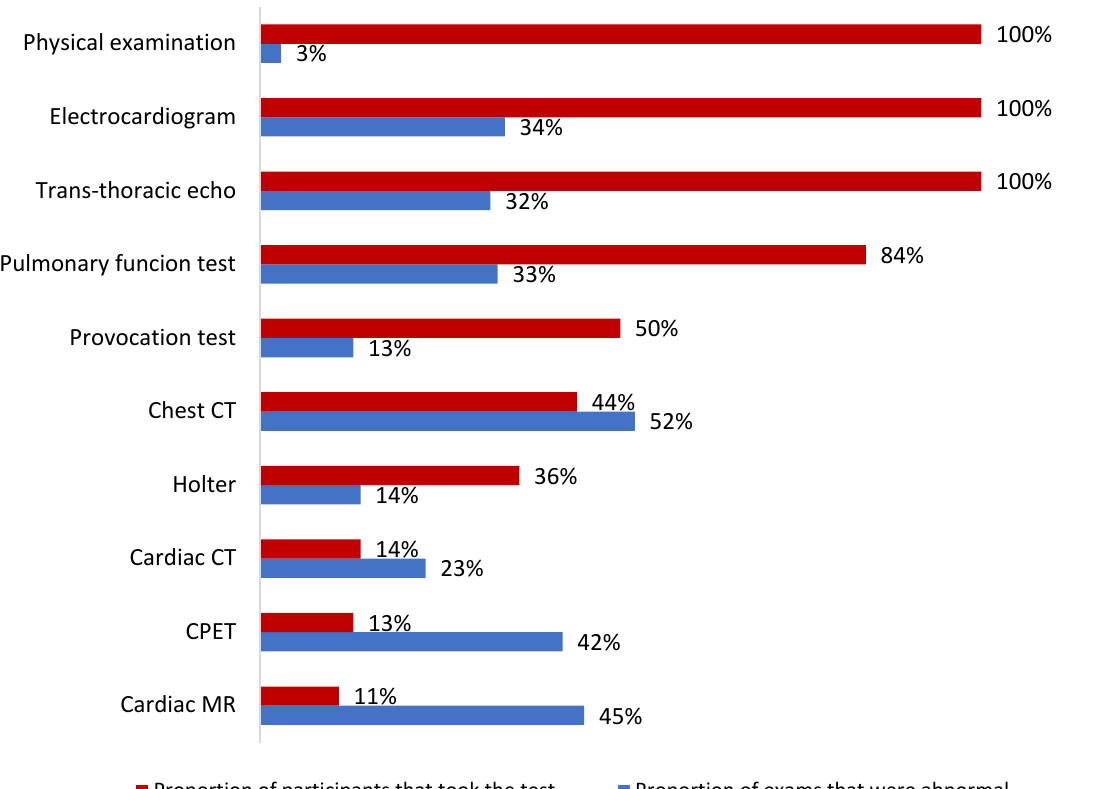
Figure 3. Diagnostic tests performed on the study cohort. While basic work-up proved negative in most patients examined for presumed cardiovascular sequelae, more advanced tests revealed pathologic findings at a higher frequency. Notably, most chest CT studies displayed anomalies. CPET = cardiopulmonary exercise test; CT = computed tomography; MR = magnetic resonance.